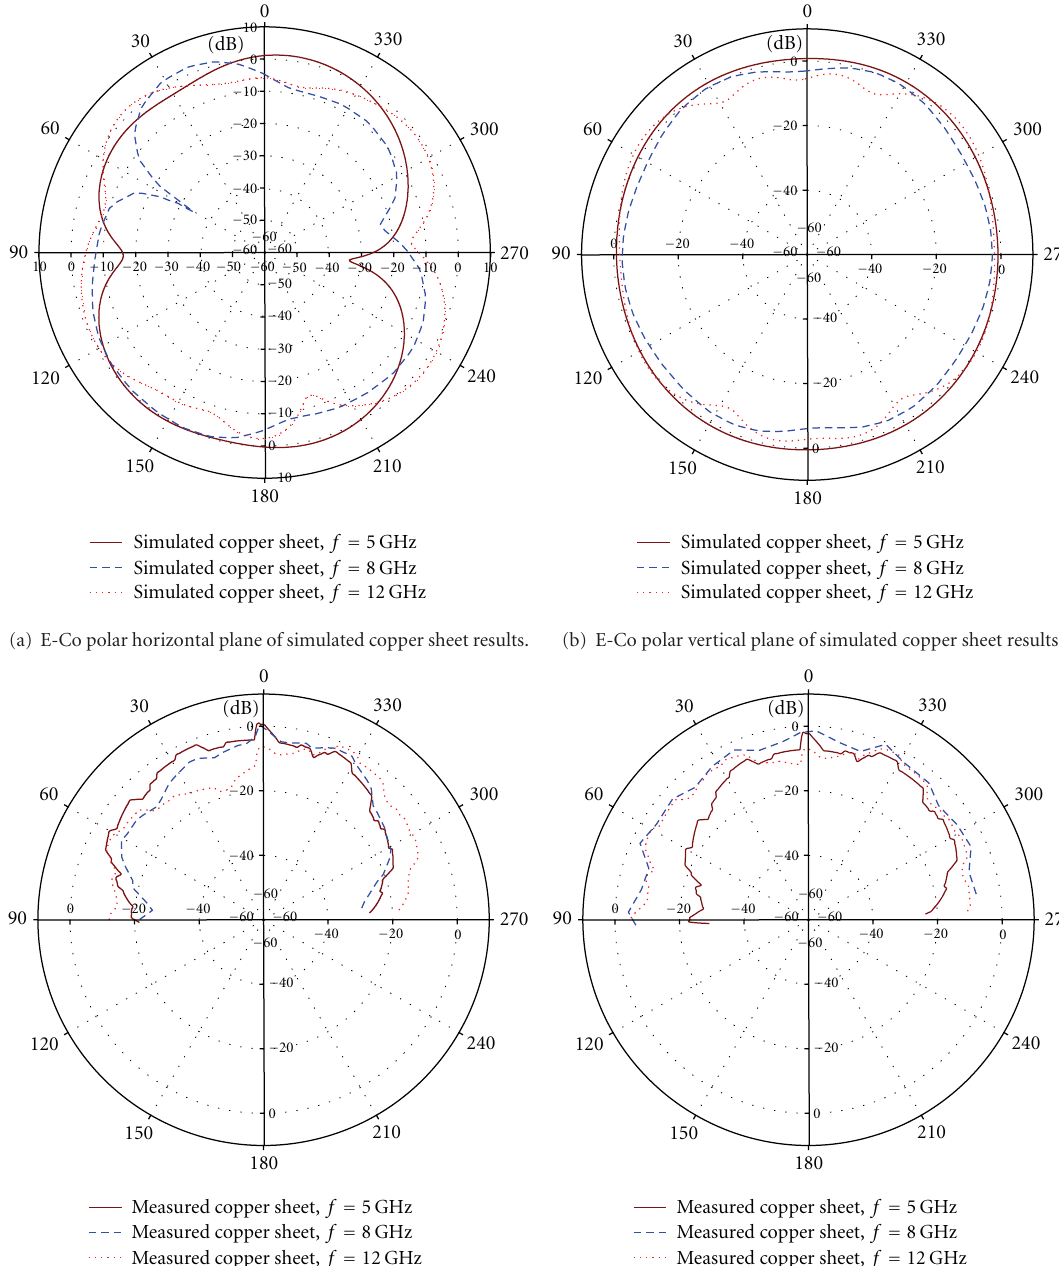
(d) E-Co polar vertical plane of measured copper sheet results. Figure 7: The behaviour of simulated and measured 2D radiation pattern results of the wearable textile UWB antenna design using copper conducting sheet considering three di ff erent selected frequency samples that represent the overall achieved